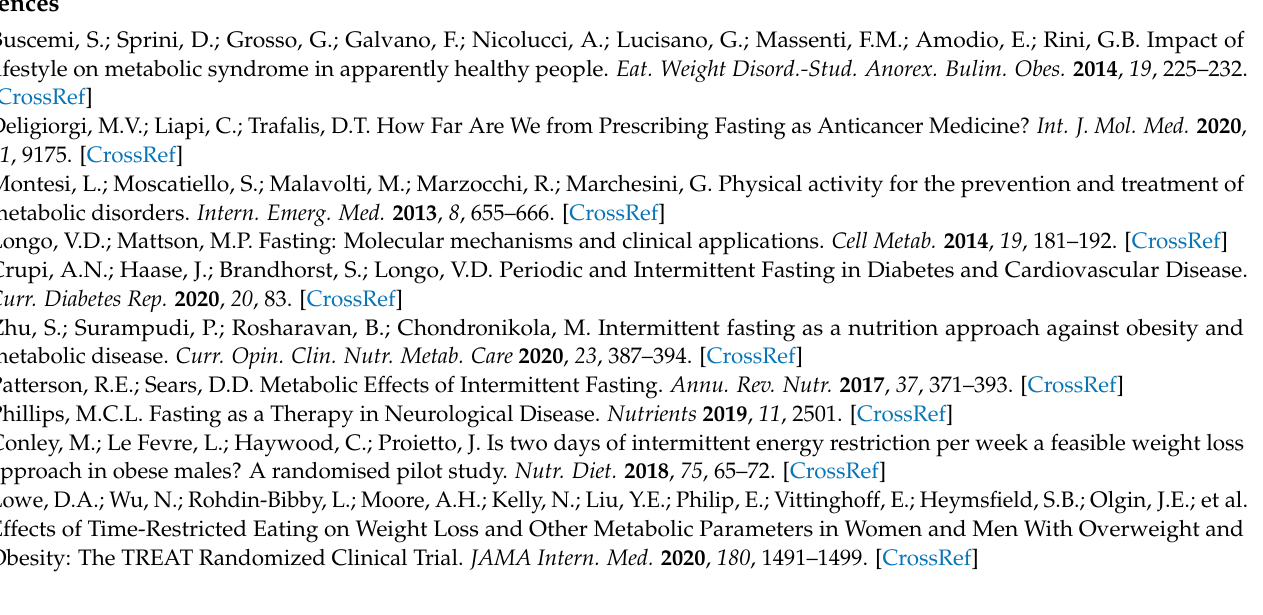
Table S1: the results of 17 blood routine